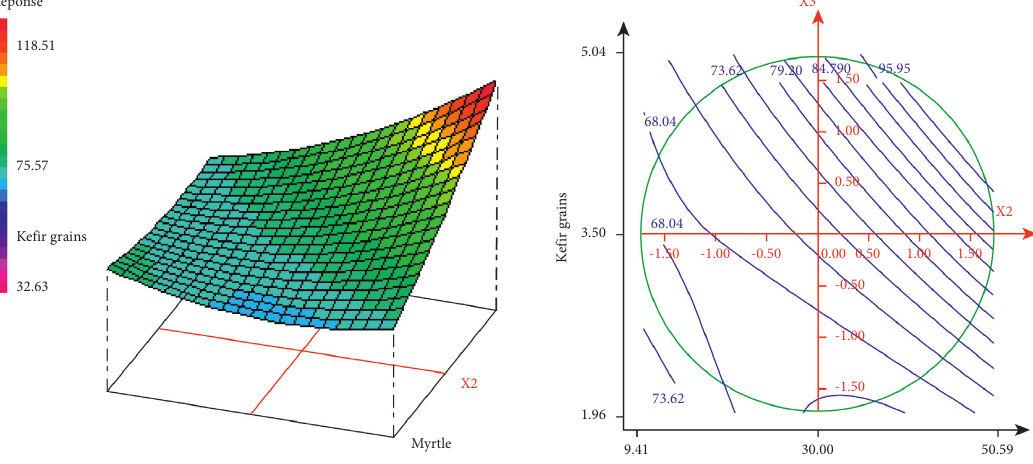
Figure 3: Response surface and contour plots representing the effect of MJ and KG on DPPH radical scavenging activity (%; X and X 3 : KG (%